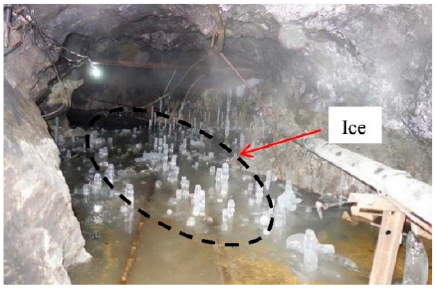
Figure 1. The frozen environment of underground stope